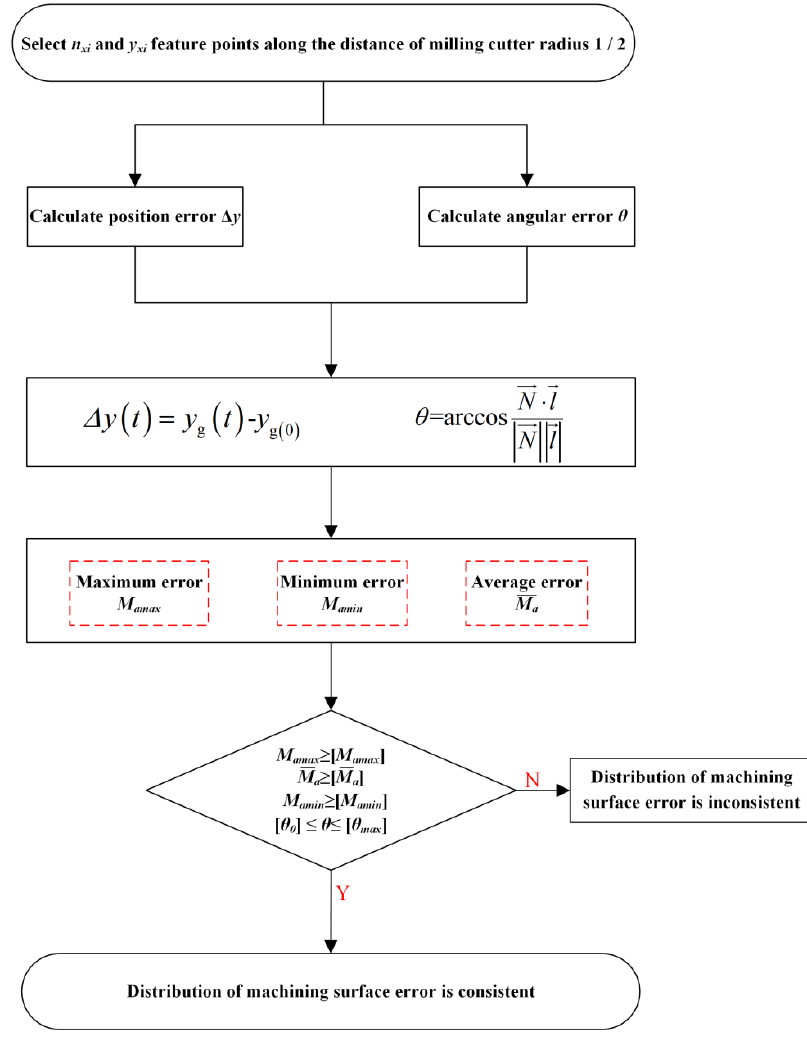
Figure 6. Consistency evaluation model of machined surface error distribution.